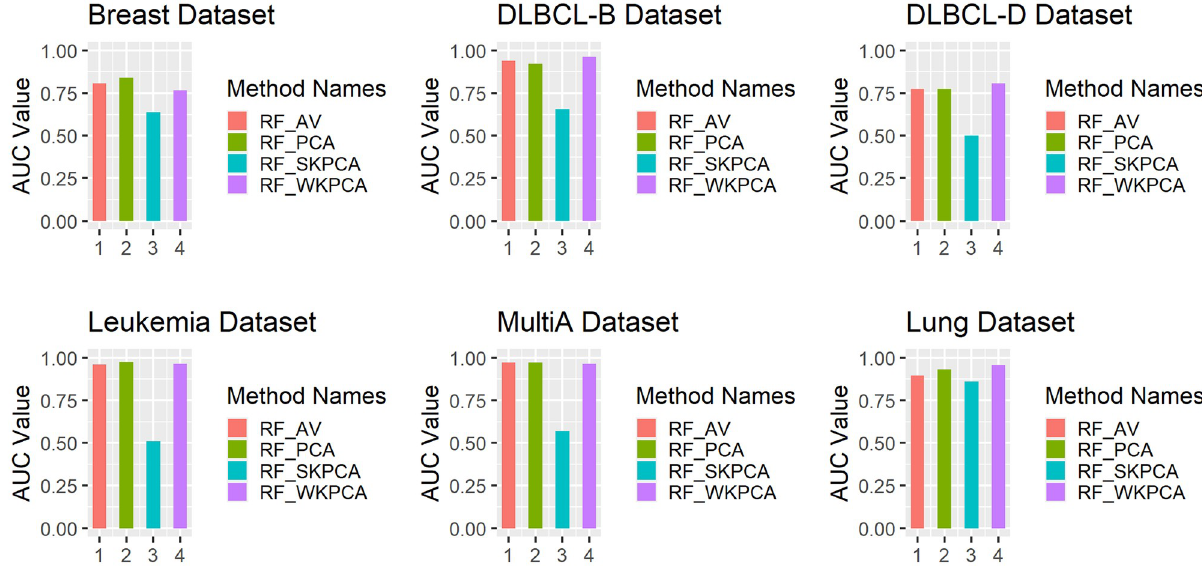
Fig 4. Comparison of the RF_AV, RF_PCA, RF_SKPCA and RF_WKPCA method AUC values.